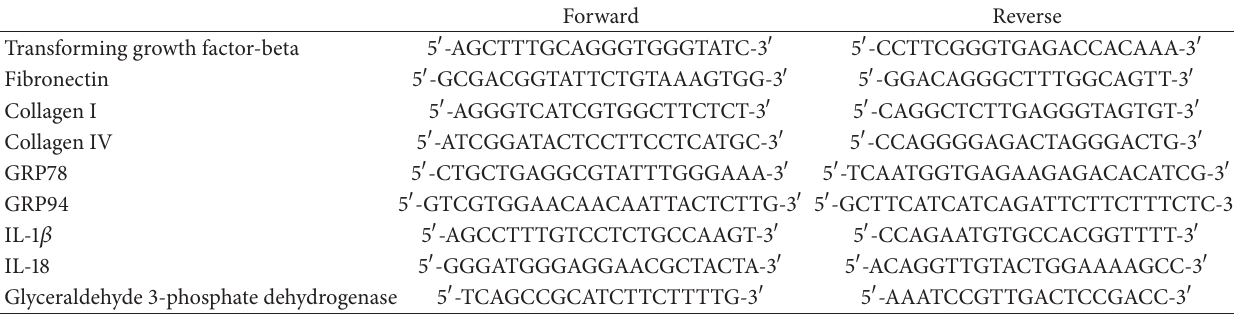
Table 1: Oligonucleotides synthesized by Invitrogen (Carlsbad, CA, USA).